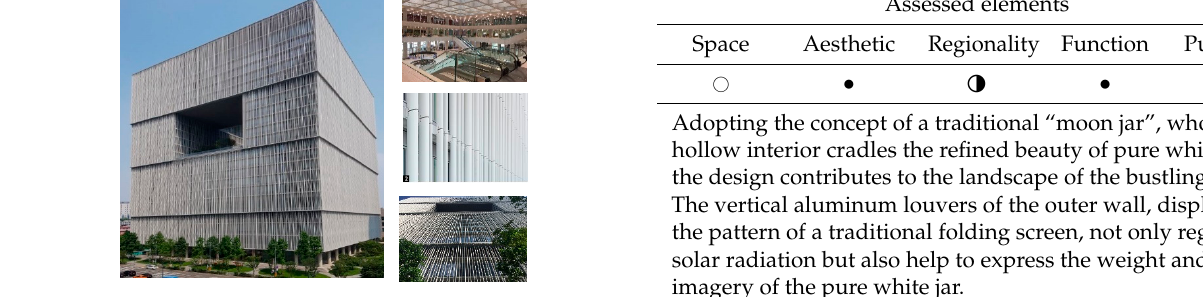
Table 3. Structural facades: Urban Hive (Archium 2008). Assessed elements Space Aesthetic Regionality Function